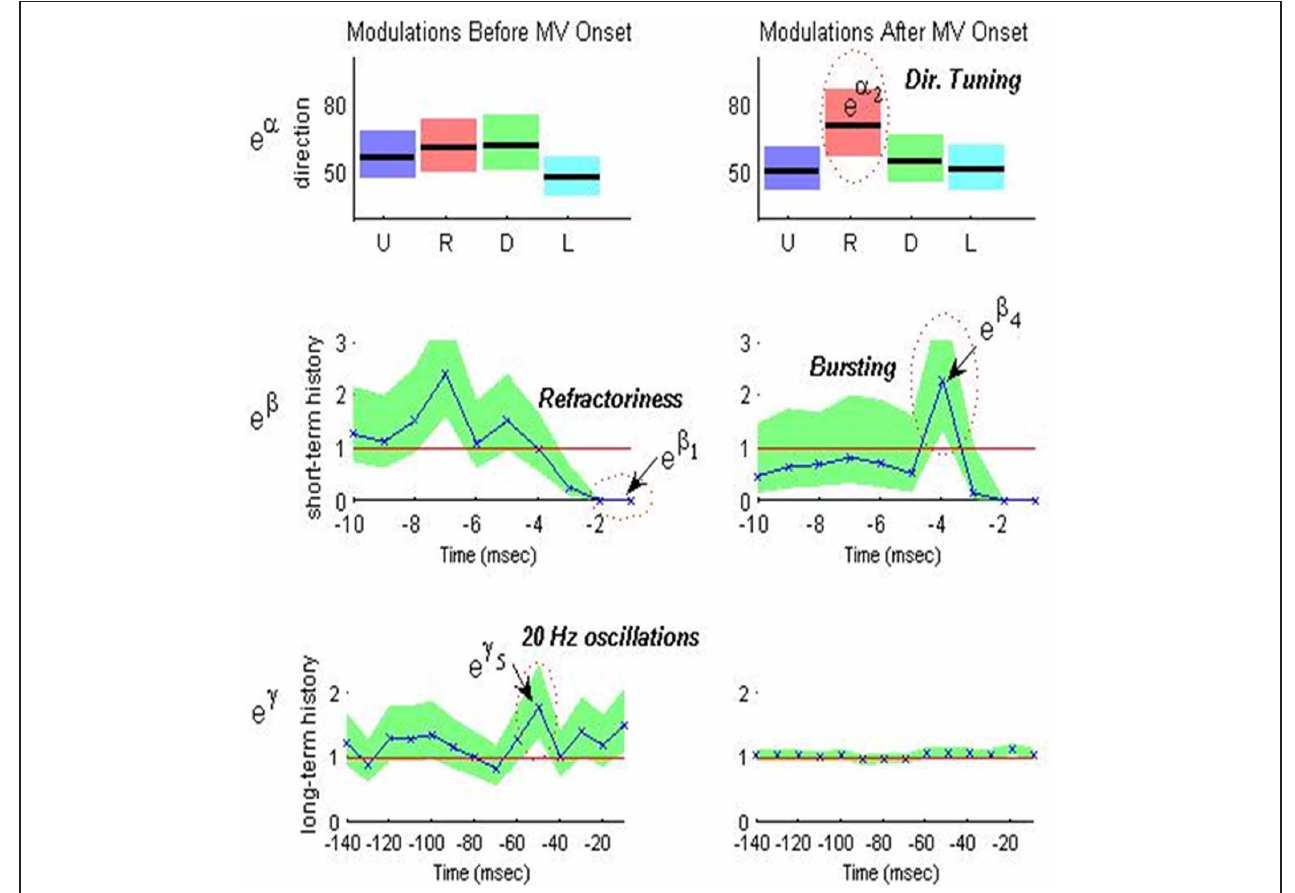
FIGURE 3 | Optimal model parameters for an STN neuron during MV– and MV + periods of a PD patient executing predicted-cued trials before movement (left) and after movement (right). Top row (movement direction modulation): optimal extrinsic factors e α d for d = 1 , 2 , 3 , 4 (U,R,D,L) are plotted in black lines from left to right and corresponding 95% confidence intervals are shaded around each black line in a unique color for each direction. Middle row (short-term